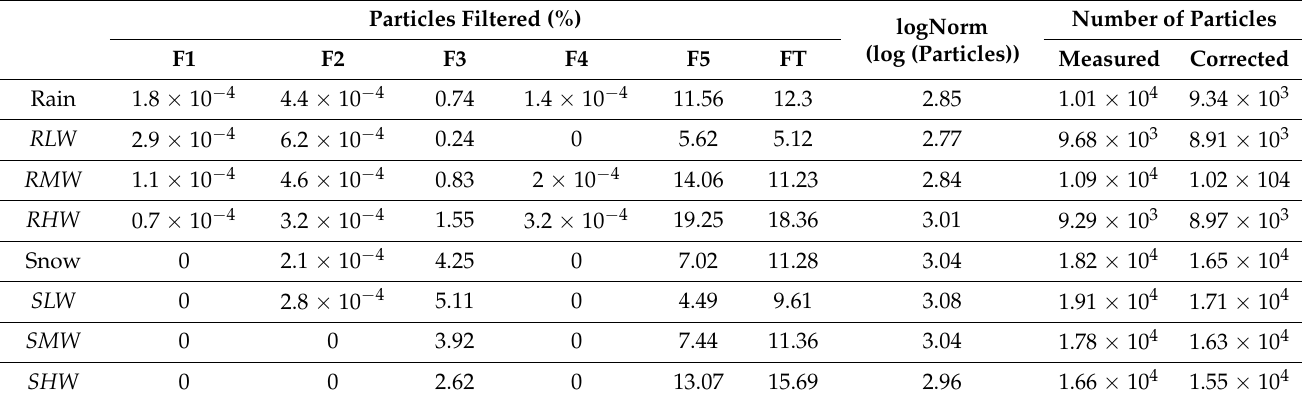
Table 7. Mean percentages of removed particles by each filter applied in each group respect to measured DSDs . To account the changes of DSDs after filters/corrections, the mean logNorm value and the mean number of particles before and after corrections were